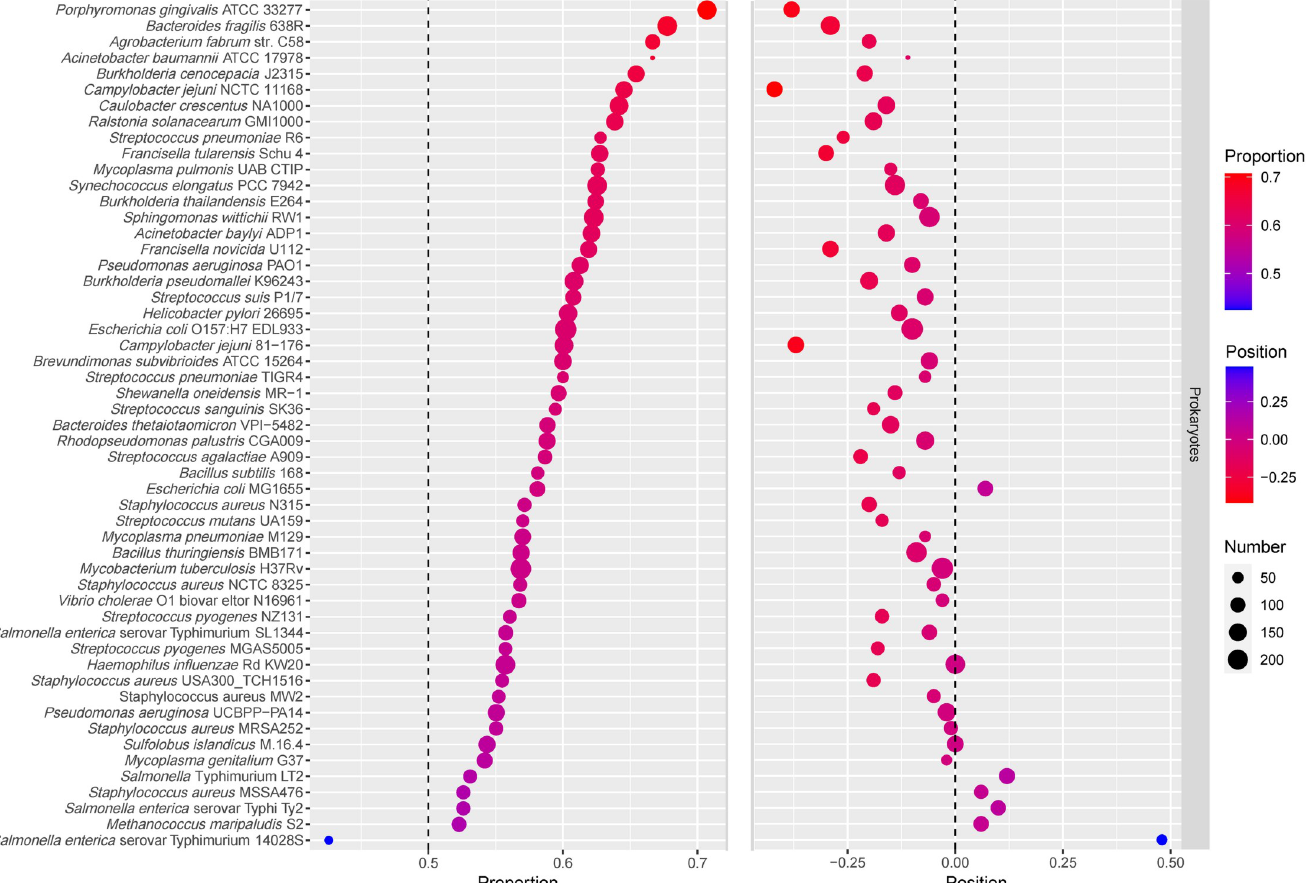
Fig 2. Bubblechart of essential genes proportion and the relative positions. In the left part of the figure, the size of the dot represents the number of essential genes occupying the first half of operons, and the color of the dot represents the proportion of essential genes occupying the first half of operons. The part on the left is sorted according to the proportion of essential genes in the first half of operons from high to low. In the right part of the figure, the size of the dot represents the number of operons, and the color of the dot represents the relative positions of essential genes.